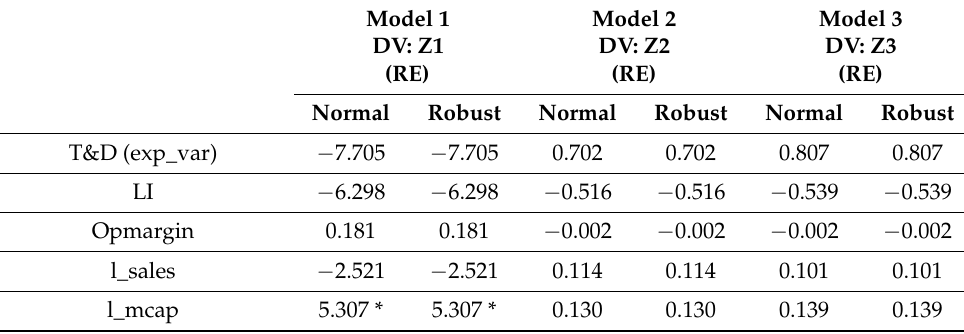
Table 4. Base Models Result for Linear Relation (Static Panel Data